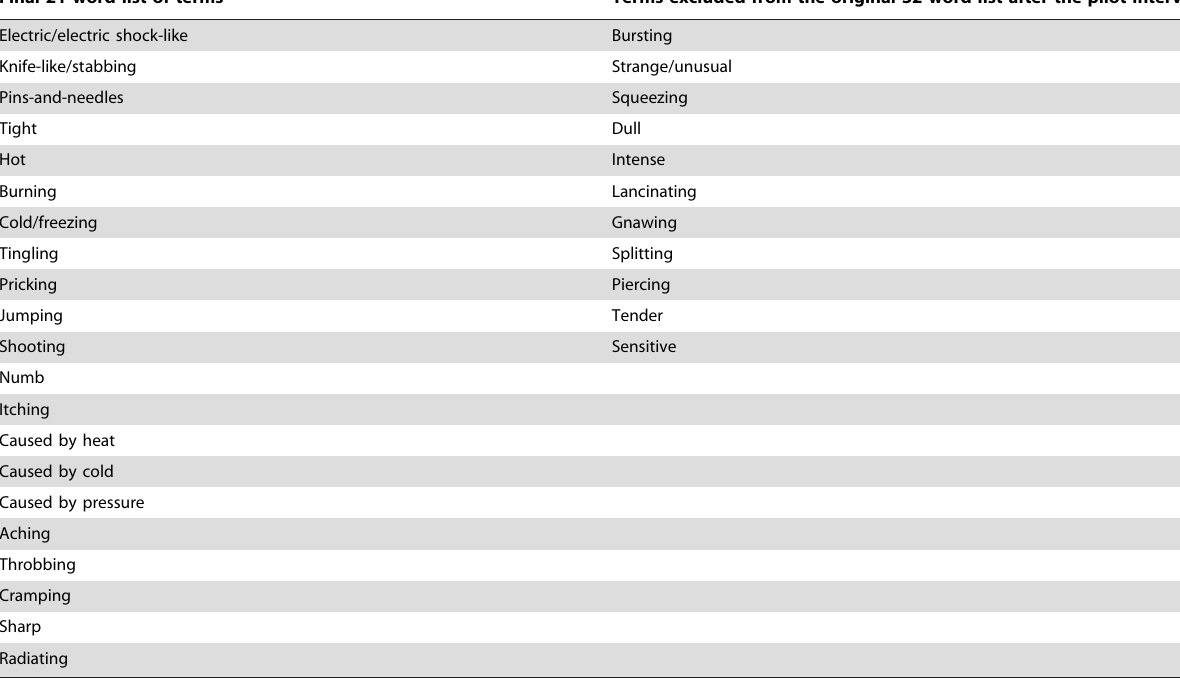
Table 1. List of English pain descriptors read to participants.